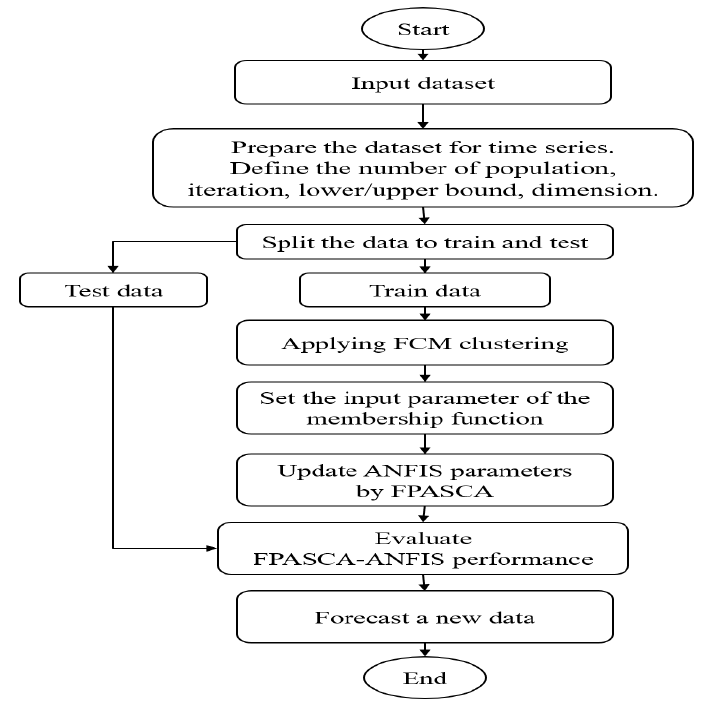
Figure 2. The workflow of the FPASCA-ANFIS